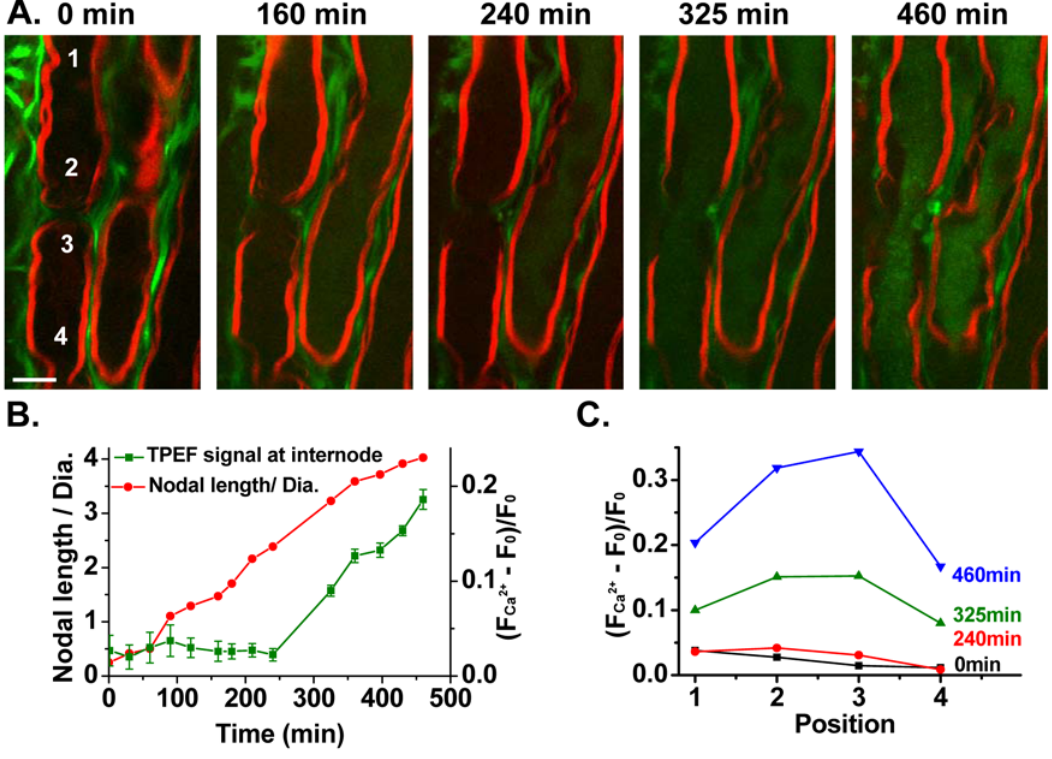
Figure 6. Paranodal myelin retraction precedes axonal injury. (A) Simultaneously acquired CARS image of myelin sheath (red) and TPEF image of a calcium indicator, Oregon green 488 AM (green), including a node of Ranvier during glutamate treatment. The Ca 2 + influx observed at 240 min was preceded by paranodal myelin splitting and retraction, which began at 60 min of glutamate treatment. Bar=10 m m. (B) Ratios of nodal length to diameter for the node in (A) and intra-axonal TPEF signals recorded at different time points. F Ca2 + represents the TPEF intensity from Ca 2 + indicator Oregon green 488 AM. F 0 is the background intensity. (C) The TPEF signal of Oregon green 488 AM at different positions marked in (A, 0 min) varied after glutamate application for 0 min (black), 240 min (red), 325 min (green) and 460 min (blue), respectively. The signal elevation trends at the four positions implicate that Ca 2 + conceivably flew into axons via the exposed paranodes and juxtaparanodes and then spread into the internodal